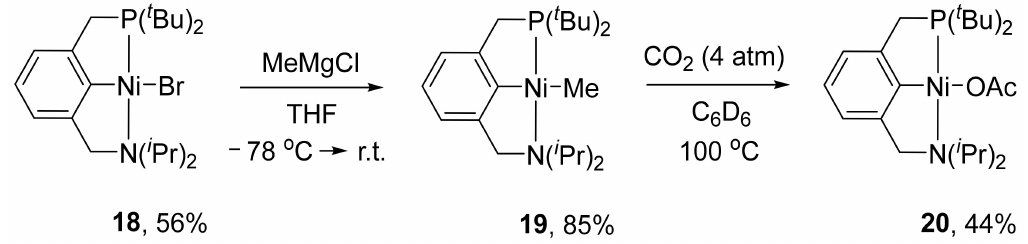
Scheme 7. Synthesis of unsymmetrical PCN pincer nickel complexes 19 and 20 [98]. In 2019, Luconi et al. demonstrated a synthesis of PCN nickel complexes containing ditertbutylphosphine and pyrazolyl fragments and different halogens in the structure (F, Cl, Br, I; see Scheme 8) [88]. The electrochemical properties of the obtained complexes 21a - 21d were investigated using cyclic voltammetry and in situ EPR